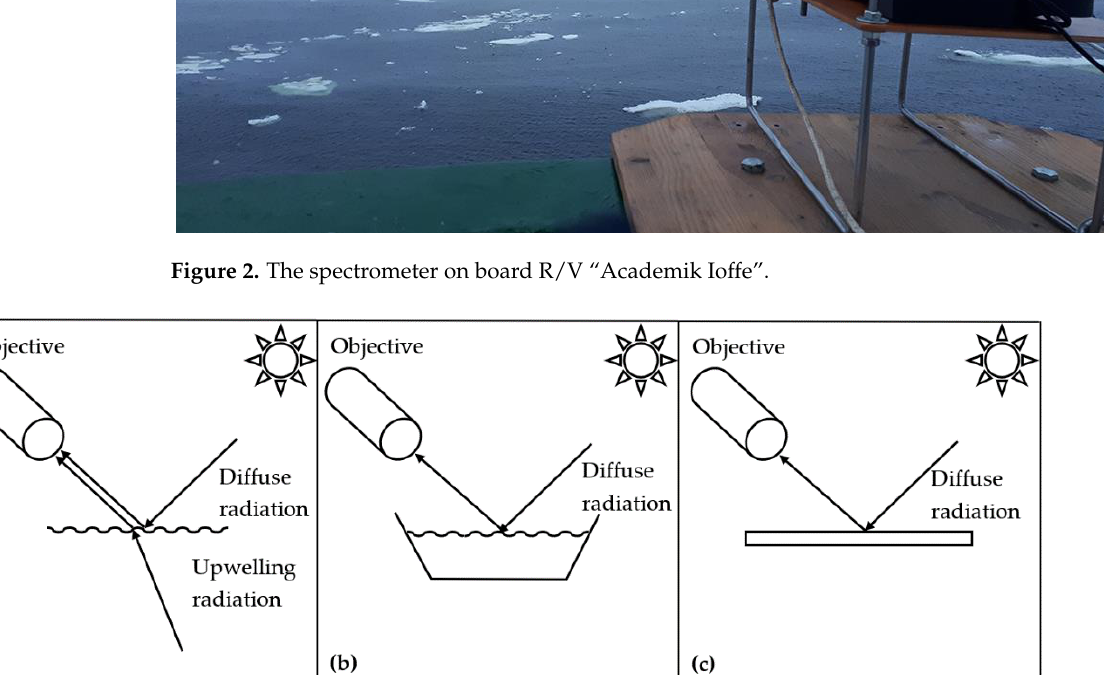
Figure 3. The measurement scheme: ( a ) the total upwelling radiance, ( b ) the radiance reflected from the water surface, and ( c ) the radiance reflected from the white panel.